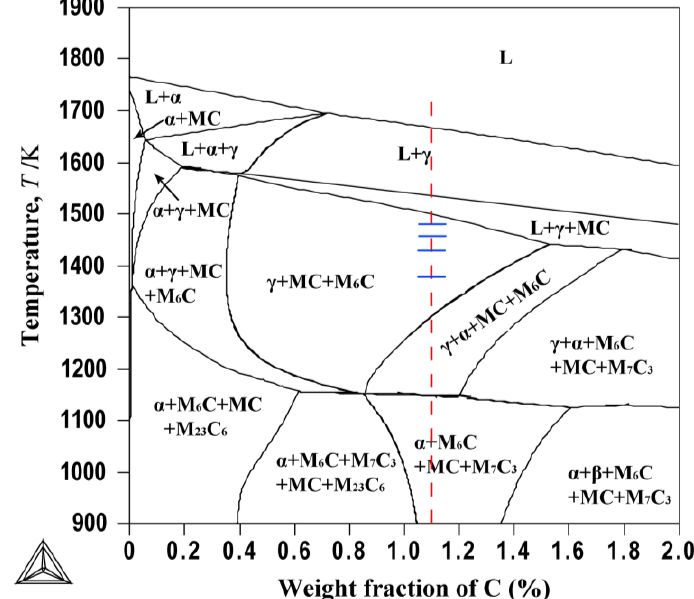
Figure 3. Phase equilibrium diagram of AISI M42 HSS calculated using Thermo-Calc software. A dotted vertical line means the C concentration (1.11 wt. %) of the present steel. The blue lines show the region of four different temperatures.